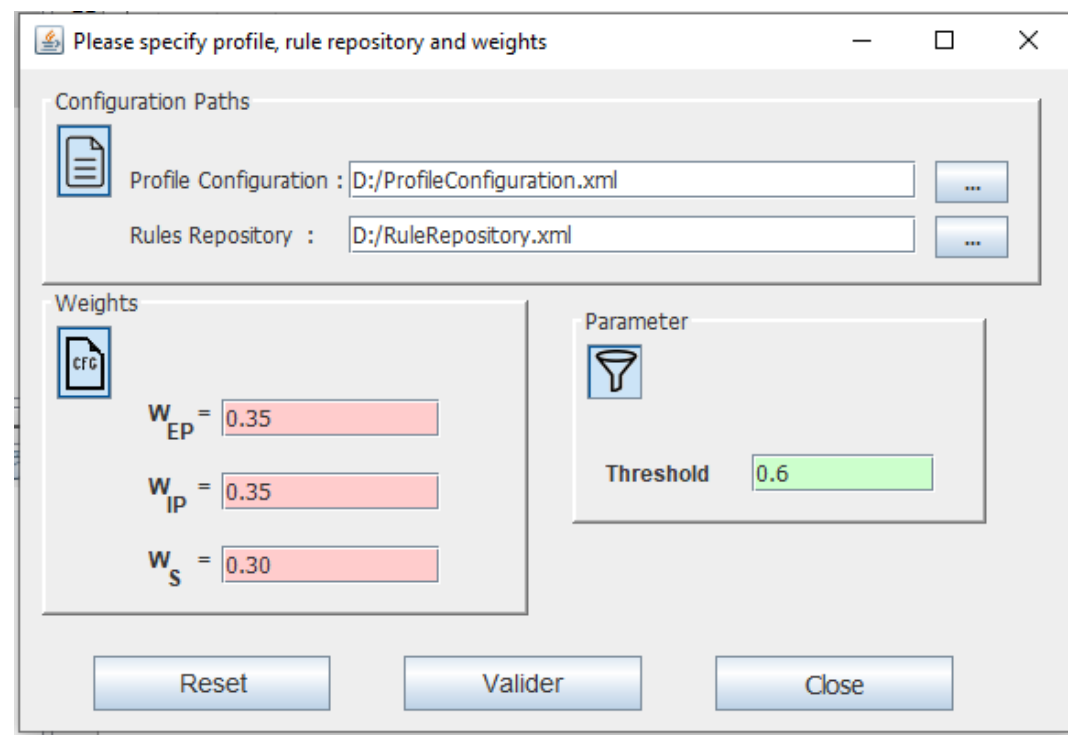
Figure 8. Similarity weights for all scenarios.